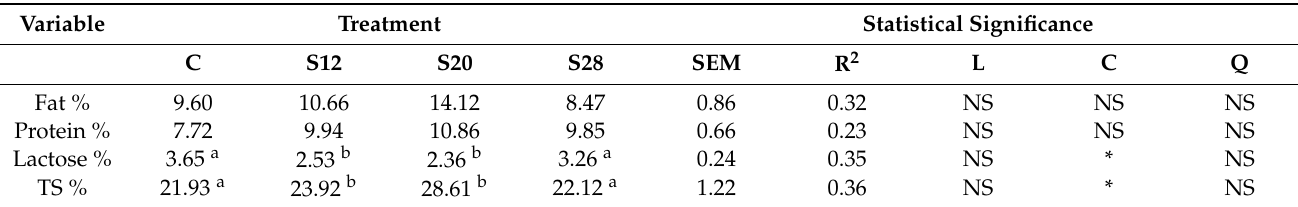
Table 4. The effect of different levels of sunflower hulls on the colostrum composition, as assessed 48 h postpartum.